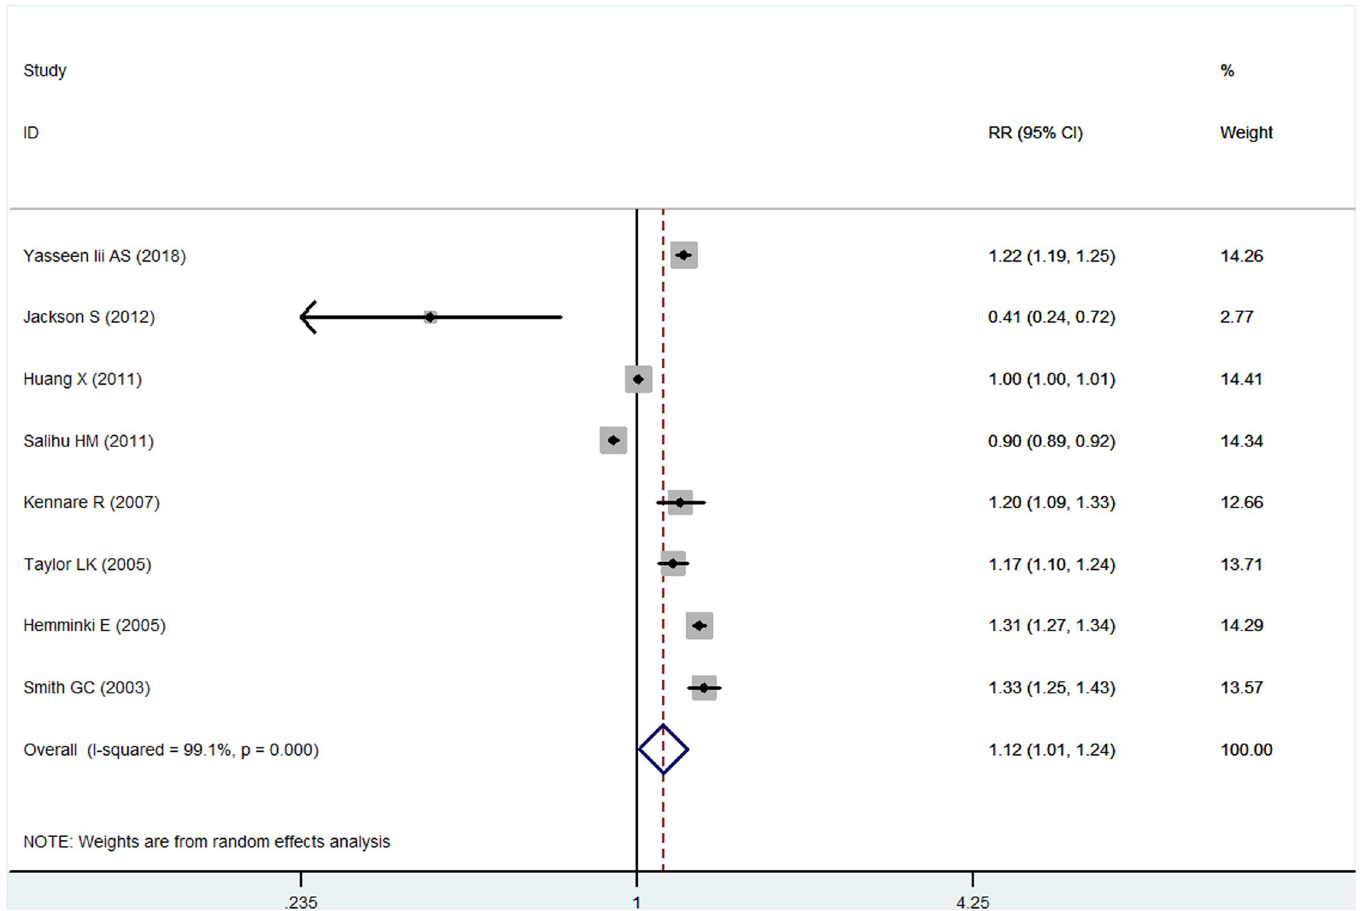
Fig 3. Pooled adjusted risk estimates of mode of delivery for preterm birth in subsequent births (cesarean section vs. vaginal delivery).